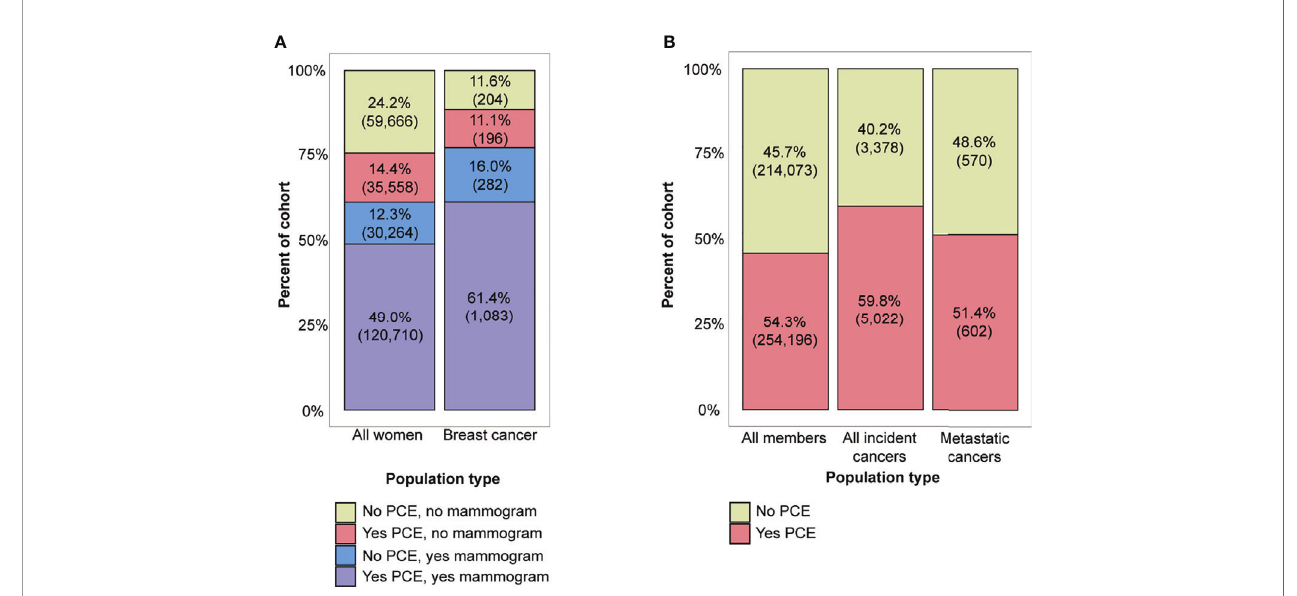
FIGURE 3 | (A) Combinations of preventive care exam (PCE) and screening mammogram utilization in the all women aged 50-64 and breast cancer cohorts, and (B) PCE utilization in the all member aged 50-64, incident cancer, and metastatic cancer cohorts. Note that percentages may not add to 100% due to